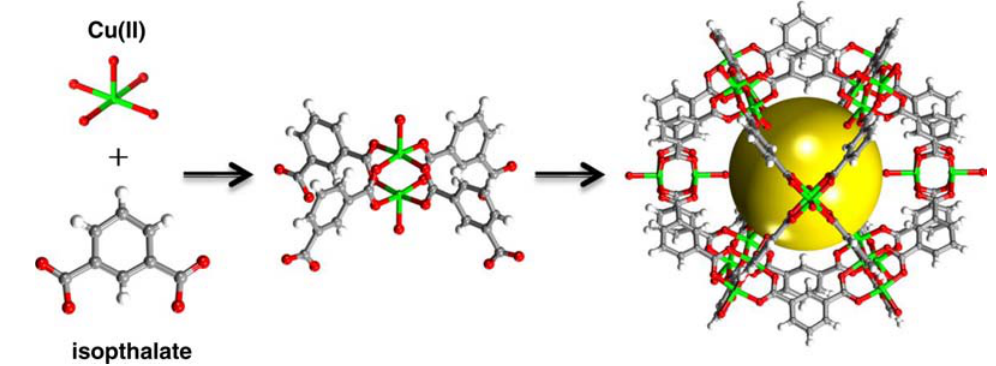
Figure 3. Synthesis of the self-assembled Cu(II) nanoball from Cu(II) and isopthalate ions. Cu (green), O (red), C (gray), H (white). Yellow sphere represents guest-accessible void inside the nanoball ( , 1nm